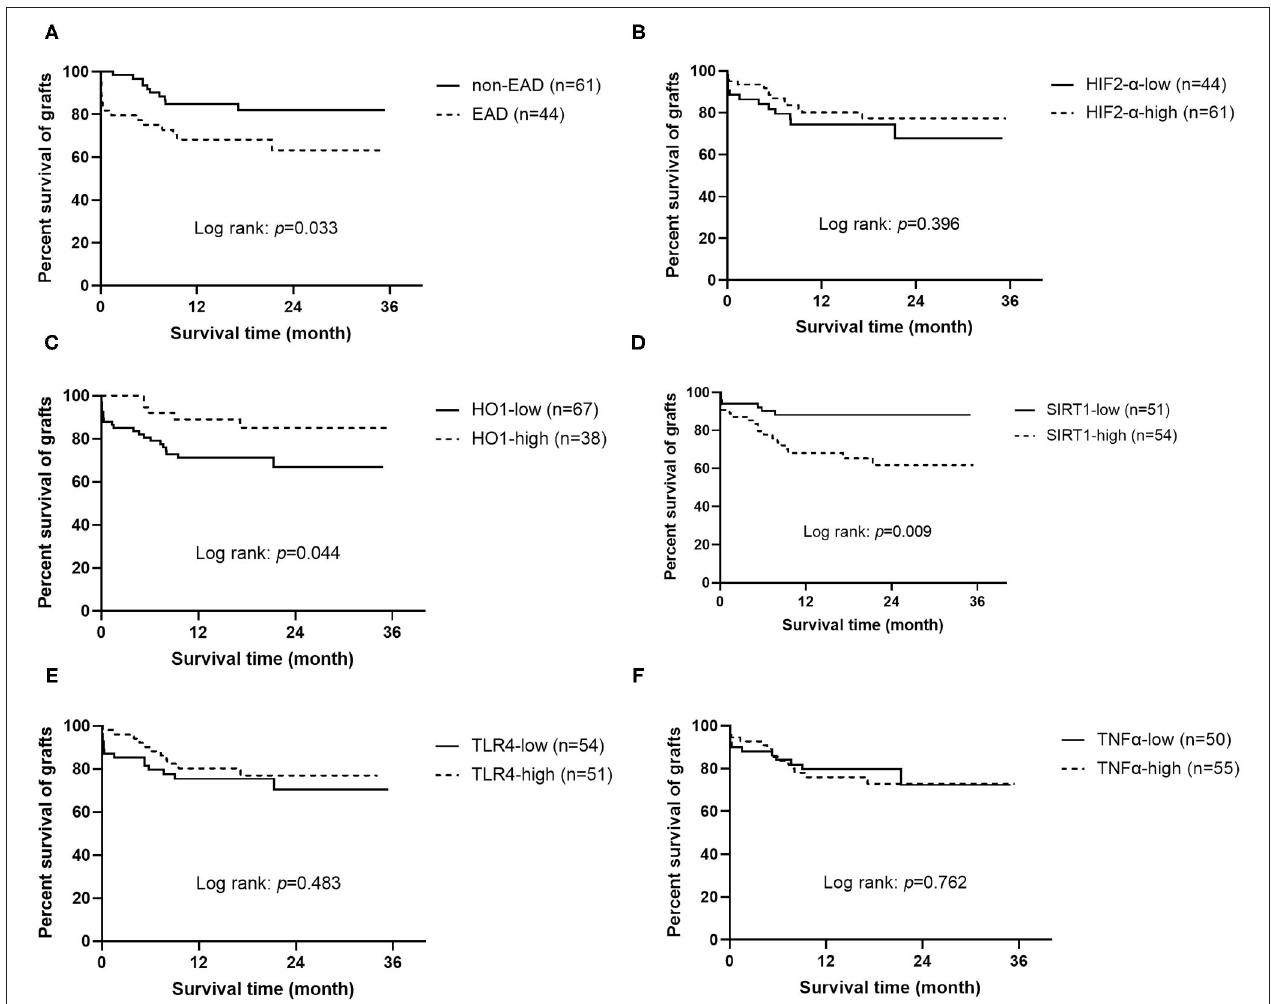
FIGURE 2 | Kaplan-Meier curves for grafts ( n = 105). (A) Graft survival according to EAD or non EAD. (B) Graft survival according to the expression level of HIF2- α . (C) Graft survival according to the expression level of HO1. (D) Graft survival according to the expression level of SIRT1. (E) Graft survival according to the expression level of TLR4. (F) Graft survival according to the expression level of TNF- α . EAD, early allograft dysfunction; HIF2- α , hypoxia-inducible factor 2- α ; HO1, heme oxygenase-1; SIRT1, sirtuin 1; TLR4, toll like receptor 4; TNF- α , tumor necrosis factor α